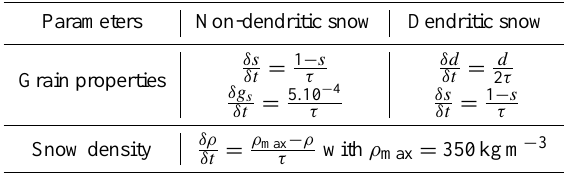
Table 3. Evolution rates of snow grain properties and density in layer i caused by snowdrifiting. t is time expressed in hours and τ represents the time characteristic for snow grains change under wind transport given by Eq. (12). Parameters Grain